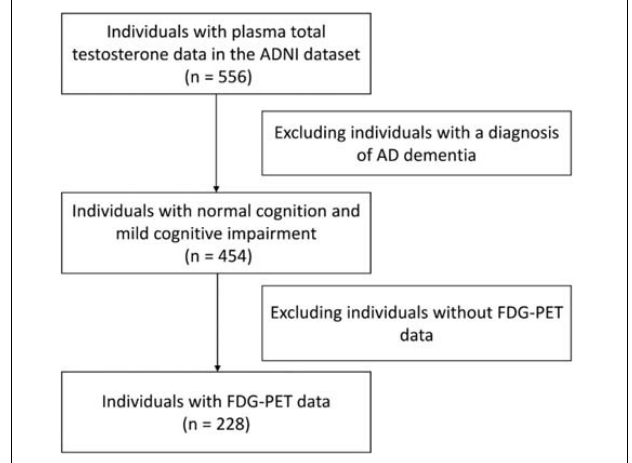
FIGURE 1 | A flowchart of the data selection at